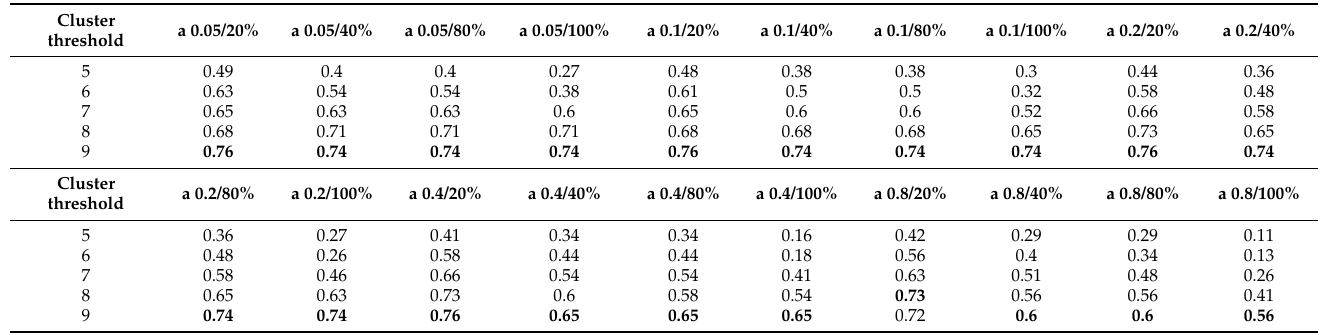
Table 2. Correlation matrix of Negribreen. Extraction every 500 m and a 250 m circular buffer compared to Haga et al. [13]. The cluster threshold marks the number of anomalies within the moving window (of the size nine) at any position per time step.